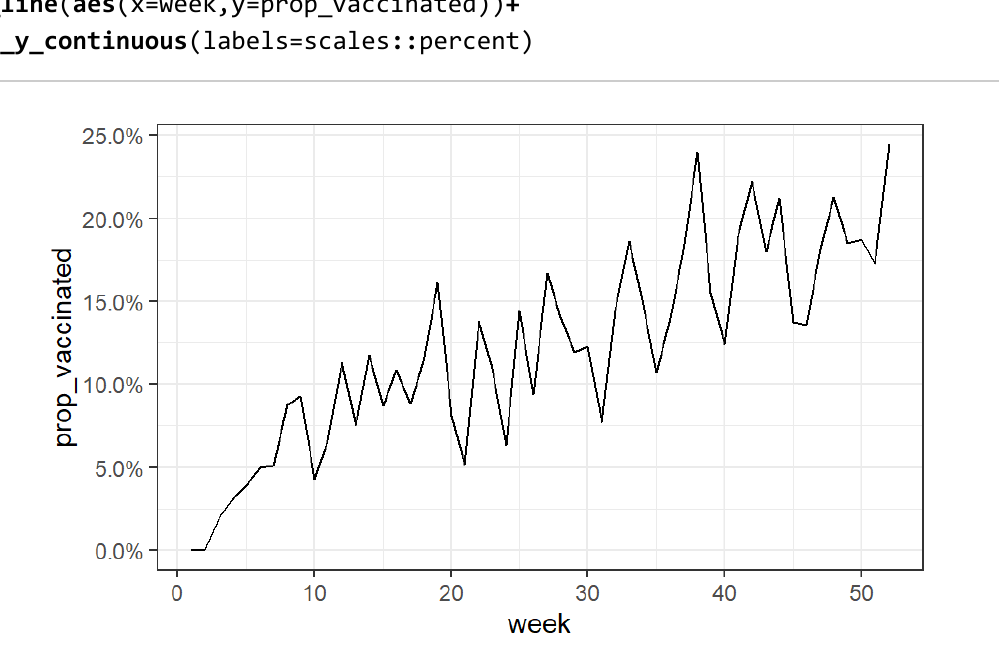
Figure S7. Simulated proportion of vaccinated among hospitalized